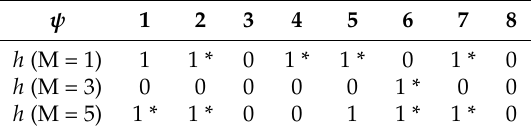
Figure 9. Median multiple stimulus test with hidden reference and anchor (MUSHRA) results with non-parametric 95% confidence intervals (CI) for each test sound location ( ψ ): ( a ) ψ = 1, ( b ) ψ = 2, ( c ) ψ = 3, ( d ) ψ = 4, ( e ) ψ = 5, ( f ) ψ = 6, ( g ) ψ = 7 and ( h ) ψ = 8. Reference and anchor scores omitted. Score indicates perceived timbral similarity between test stimulus and HRIR reference. Table 6. Hypothesis test results of the MUSHRA test results of the three Ambisonic orders for each test sound location using Wilcoxon signed-rank test (1 indicates statistical significance at p < 0.05; * indicates p <